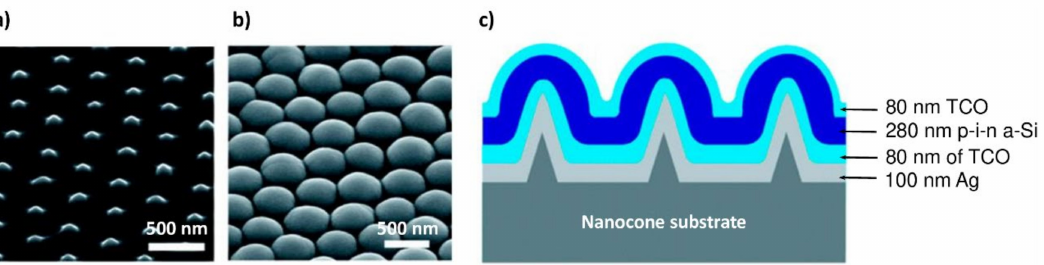
Figure 15. SEM images at 45 ◦ on ( a ) nanocone-patterned quartz substrate and ( b ) a-Si:H nanodome solar cells after deposition of all layers on nanocones (scale bar 500 nm). ( c ) Schematic illustration of the cross-sectional view of a-Si:H nanodome solar cells (Reprinted with permission from [185] 2010, American Chemical